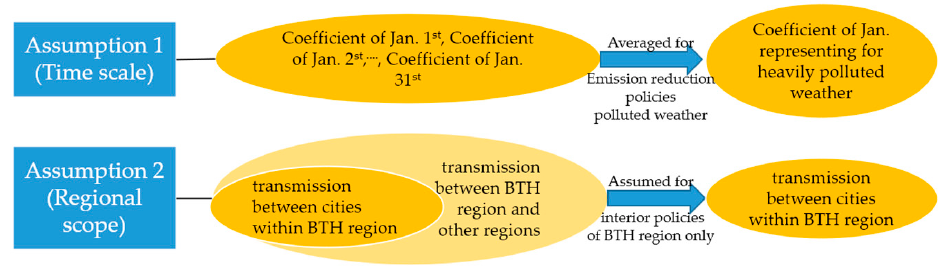
Figure 1. Interpretation of the three assumptions in this study